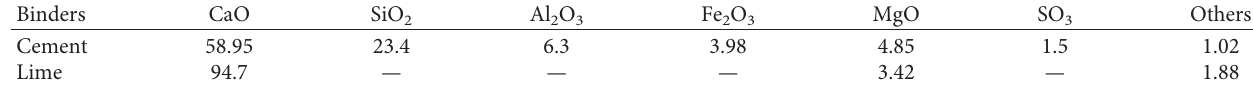
Table 2: Composition of Portland cement and lime used in this study (%).